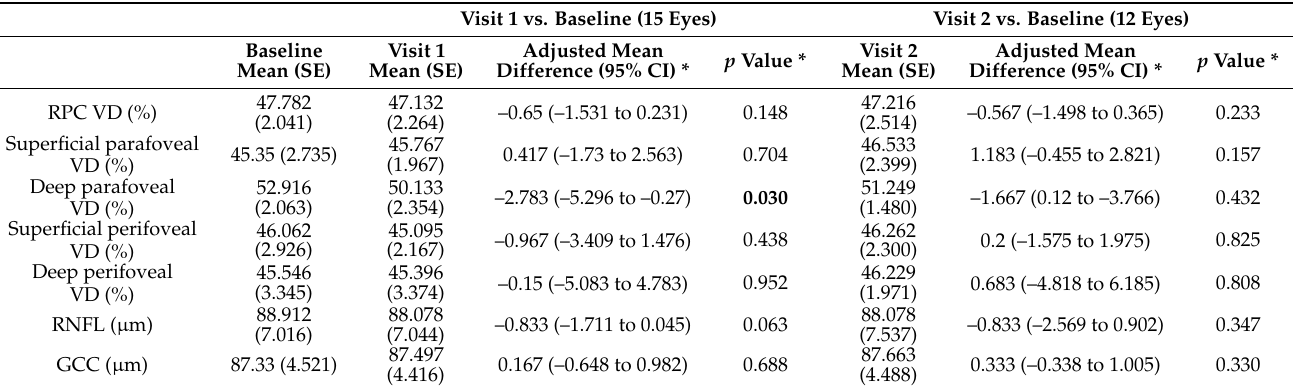
Table 5. Comparison of the OCTA parameters at baseline and follow-up visits in cases which demonstrated at least 20% IOP